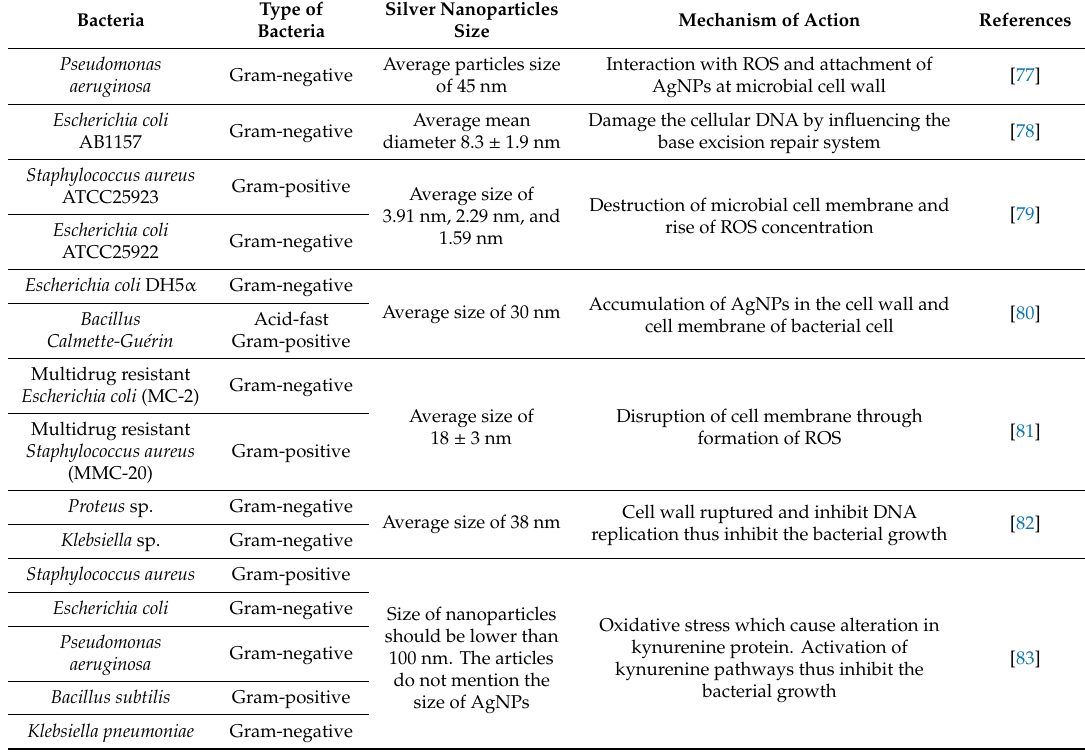
Table 4. The antibacterial properties of